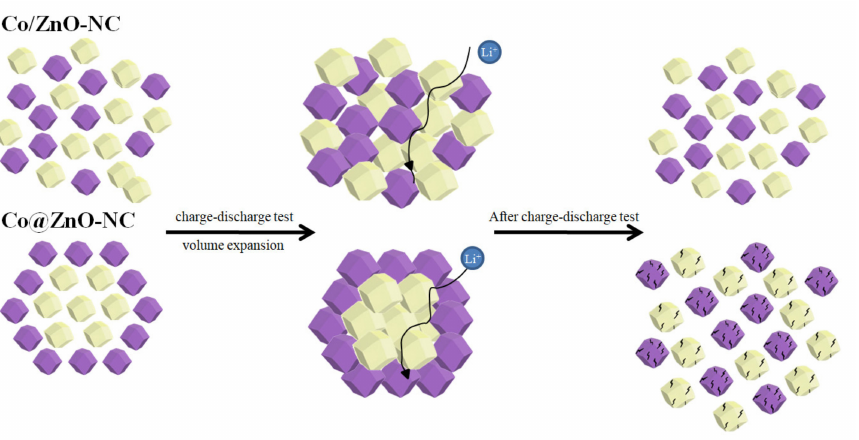
Figure 11. Schematic of Co/ZnO-NC and Co@ZnO-NC electrodes before and after discharge/ charge